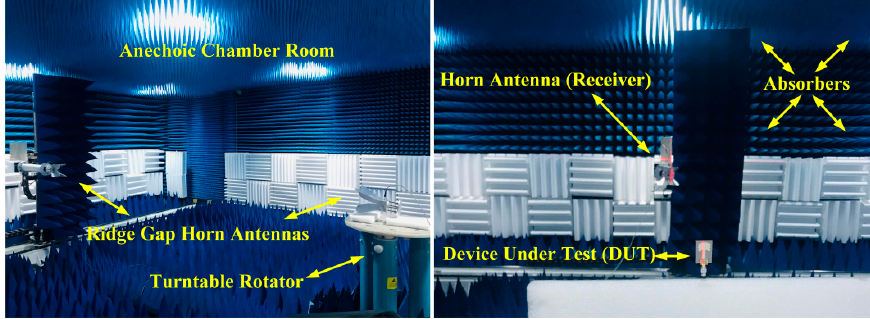
Figure 9. Placement of antennas in the anechoic chamber ridge gap horn antennas and DUT.